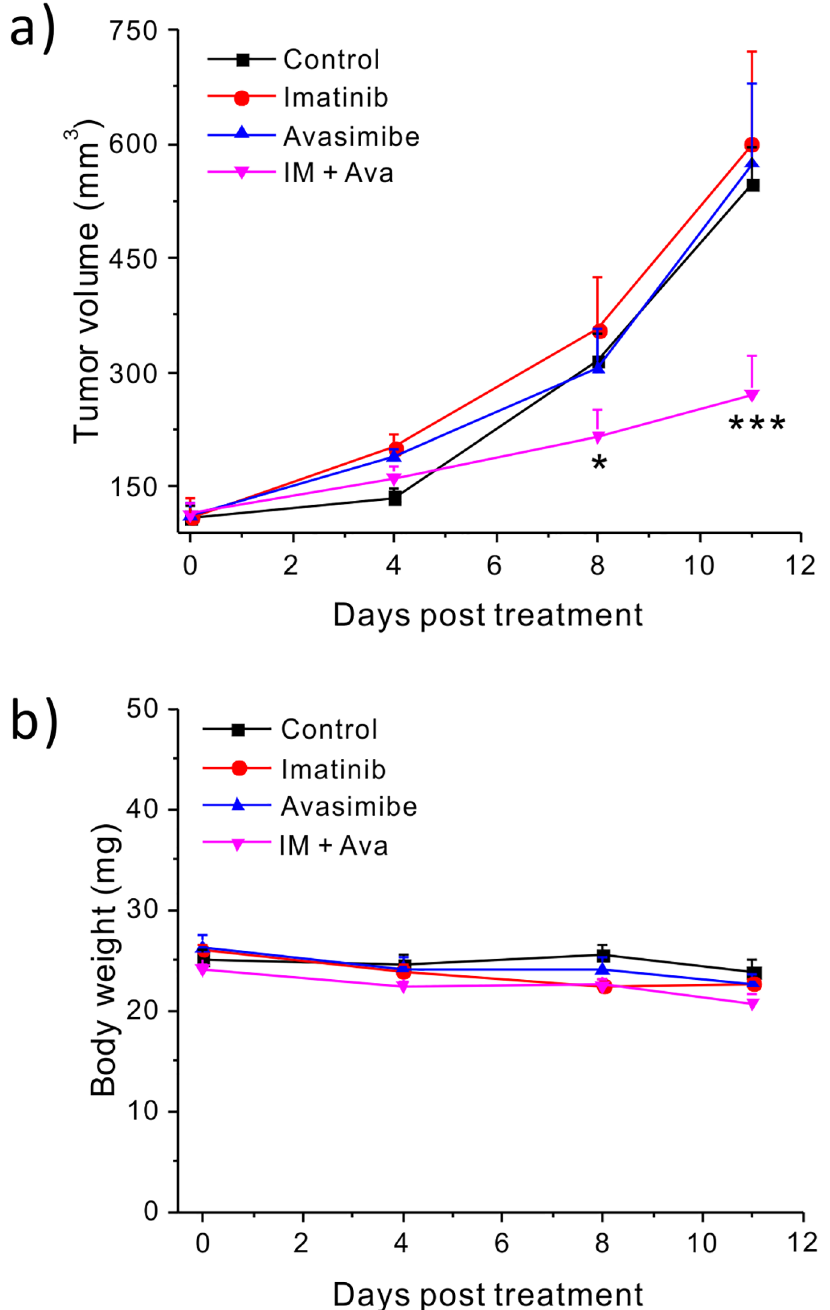
Fig 3. Imatinib and avasimibe synergistically suppress K562R xenograft tumor growth in athymic nude mice. (a) Tumor volume (mm 3 ) measured by a caliper over the course of treatment for the four treatment groups. (b) Body weight (g) of the mice throughoutthe course of treatment. The results are shown as means + SEM, n = 8. One-way student t test was used for statistical analysis, * p < 0.05, *** p < 0.001